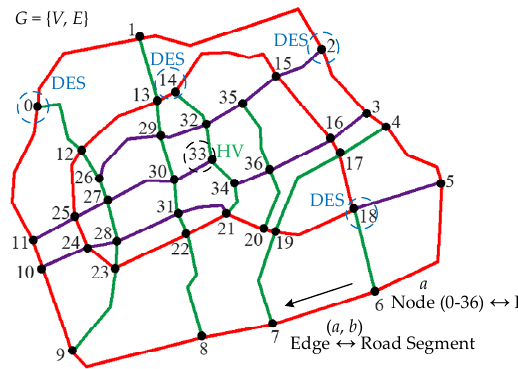
Figure 3. Graph model of traffic roads.